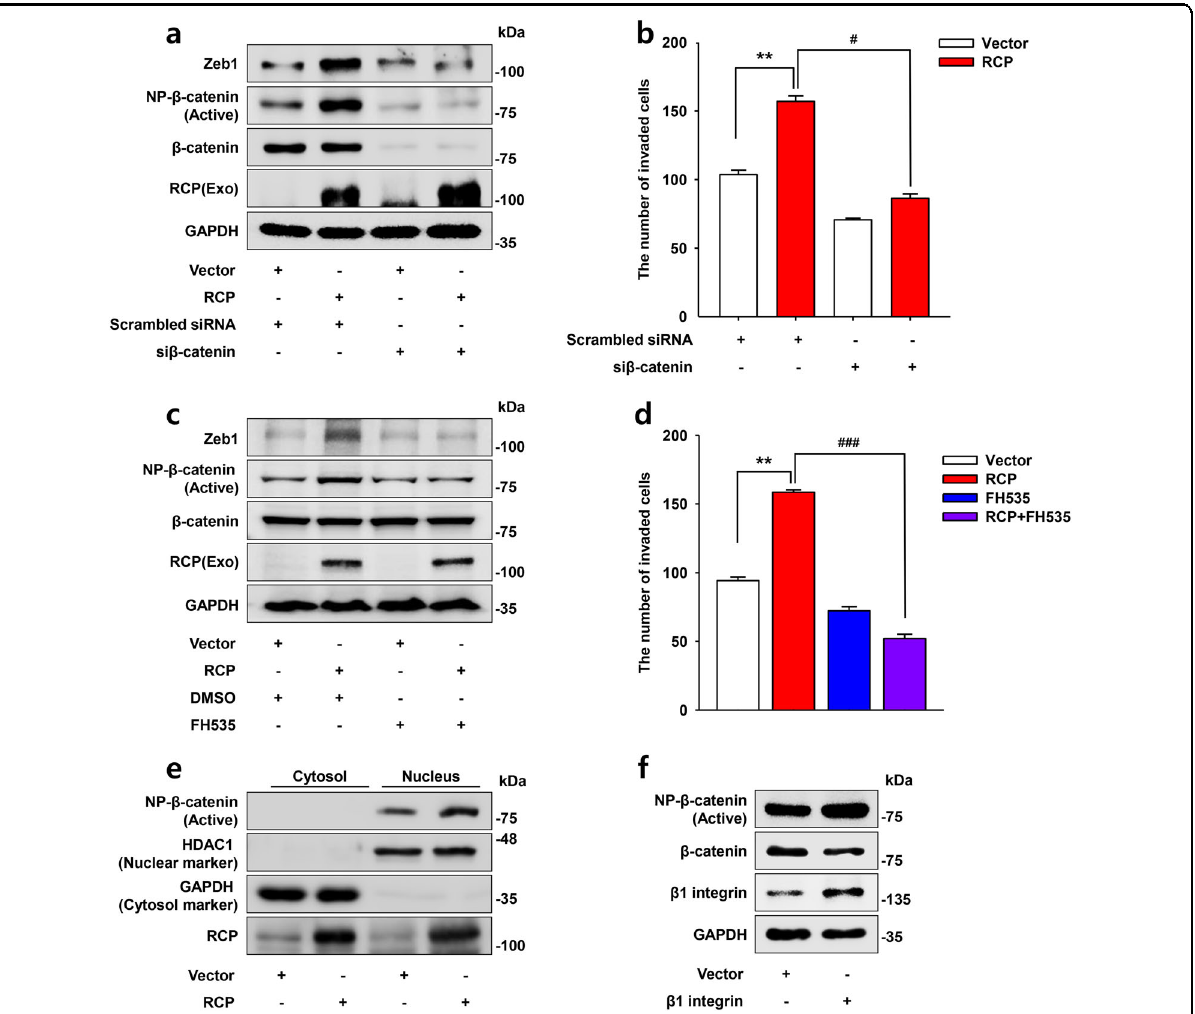
Fig. 4 The β -catenin/TCF4 complex mediates RCP-induced Zeb1 expression. a YD-10B cells were transfected with the indicated vectors and siRNAs. Immunoblotting. b YD-10B cells were transfected with the indicated vectors and siRNAs. Cell invasion assays were performed against media without any attractant (error bars, ±SD: ** p < 0.01 vs control vector, # p < 0.05 vs RCP). c YD-10B cells were sequentially transfected with RCP, serum- starved and treated with FH535 for 24 h. Immunoblotting. d YD-10B cells were transfected with RCP followed by pretreatment with FH535 for 1 h. Cell invasion assays were performed against media without any attractant (error bars, ±SD: ** p < 0.01 vs control vector, ### p < 0.001 vs RCP). e YD-10B cells were transfected with or without RCP. NP β -catenin expression was assessed by proteome extraction assay. HDAC1 and GAPDH were used as nuclear markers and cytosol markers, respectively. f YD-10B cells were transfected with or without β 1 integrin. NP- β -catenin expression was assessed by immunoblotting. The results shown are representative of three experiments with similar results and indicate the mean ± SD of three